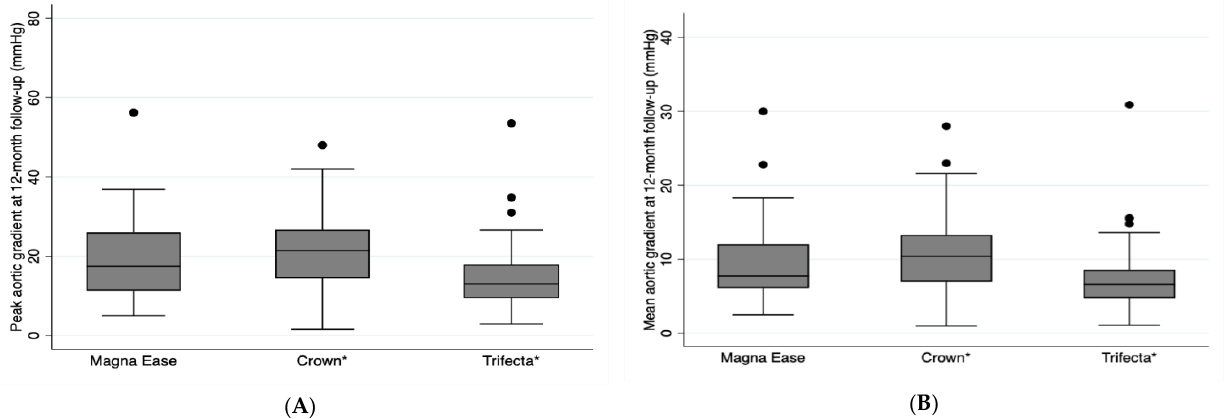
Figure 2. depicts a Box Plot of the peak aortic gradient ( A ) and the mean aortic gradient ( B ) at 12 months after surgery